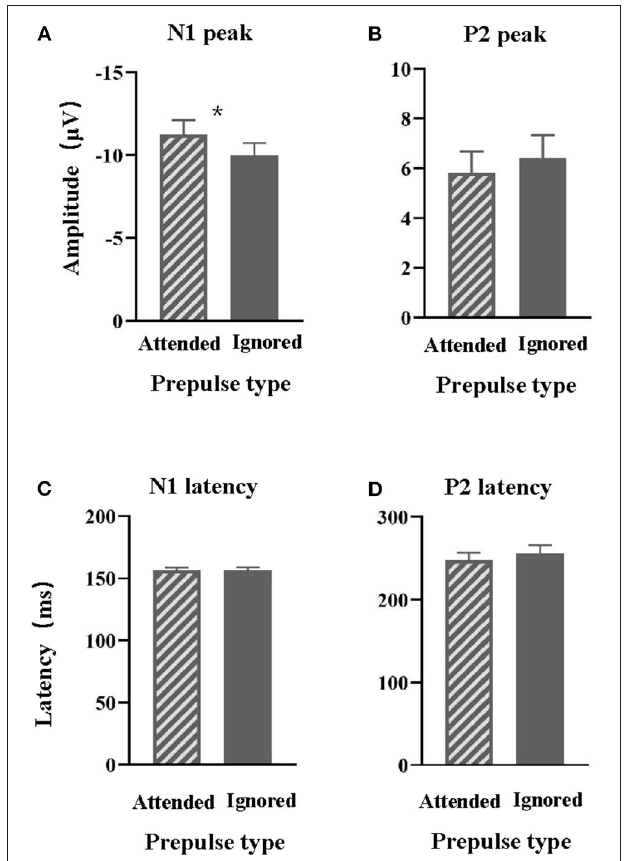
FIGURE 3 | Comparisons of the group-mean N1 (A) and P2 (B) amplitudes to the prepulse stimulus recorded at the electrode site Cz between the attended prepulse condition and the ignored prepulse condition. Comparisons of the group-mean N1 (C) and P2 (D) latencies to the prepulse stimulus recorded at the electrode site Cz between the attended prepulse condition and the ignored prepulse condition. * p < 0.05.